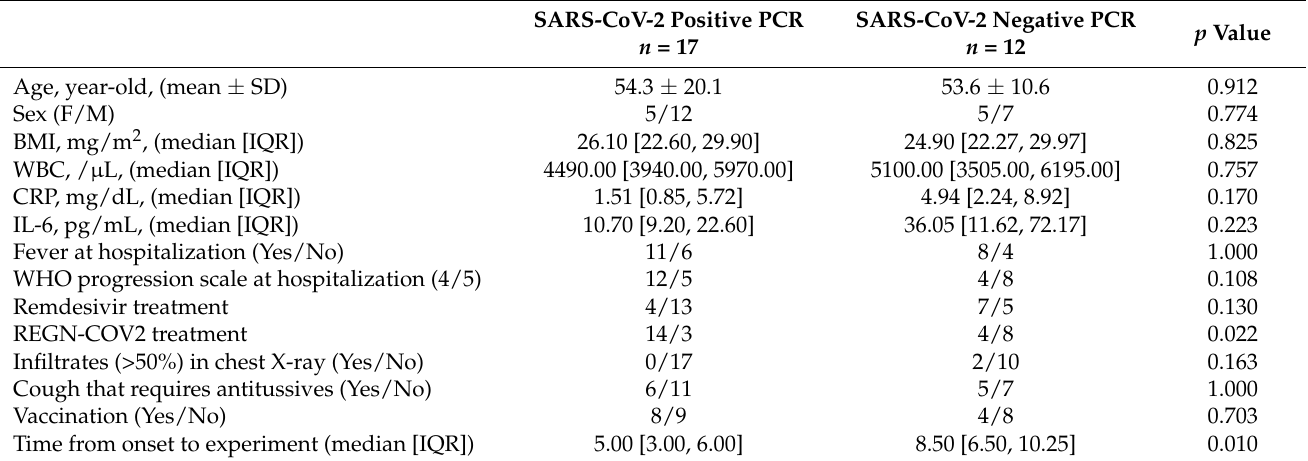
Table 1. Patient characteristics.